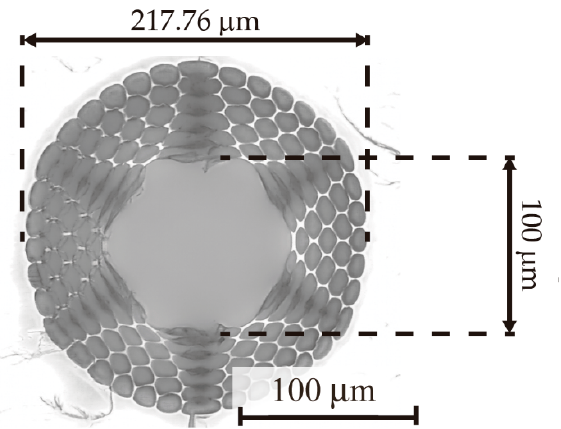
Figure 1. Cross-section microscope photograph of the HC-mPOF (microstructure. The central diameter of the microstructure is 100 μ m, the diameter of the cladding 217.76 μ m and the external diameter of the fiber is 1 mm.